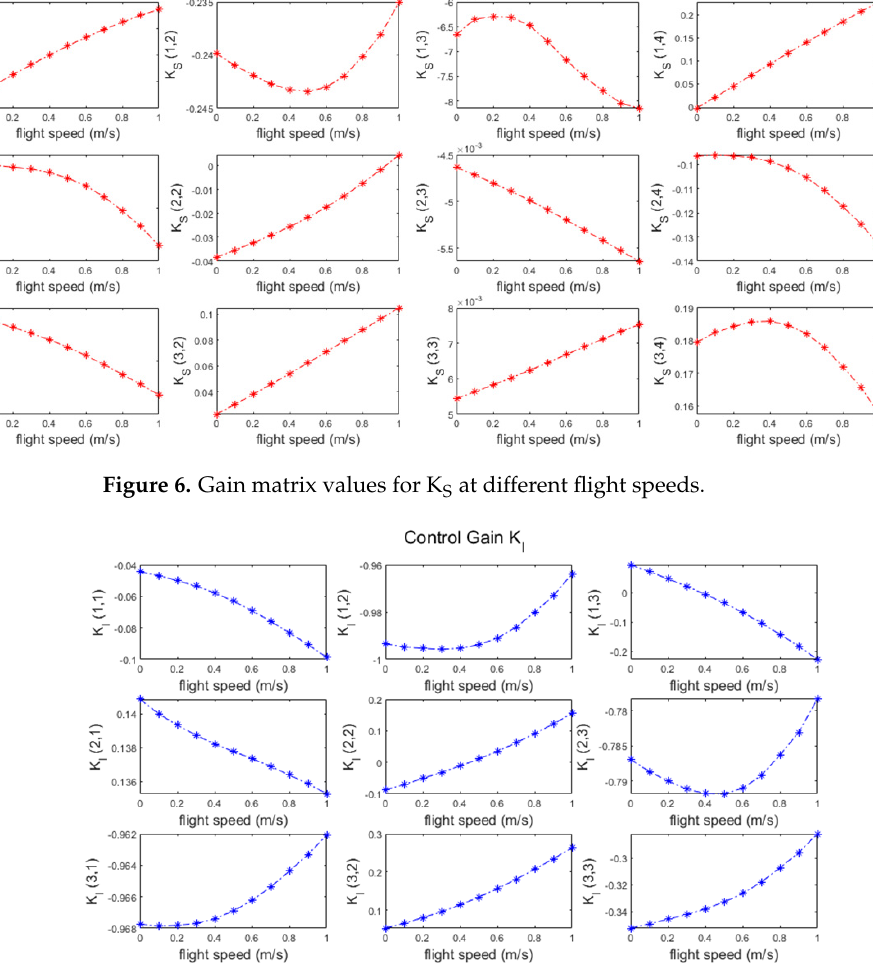
Figure 7. Gain matrix values for K I at different flight speeds.